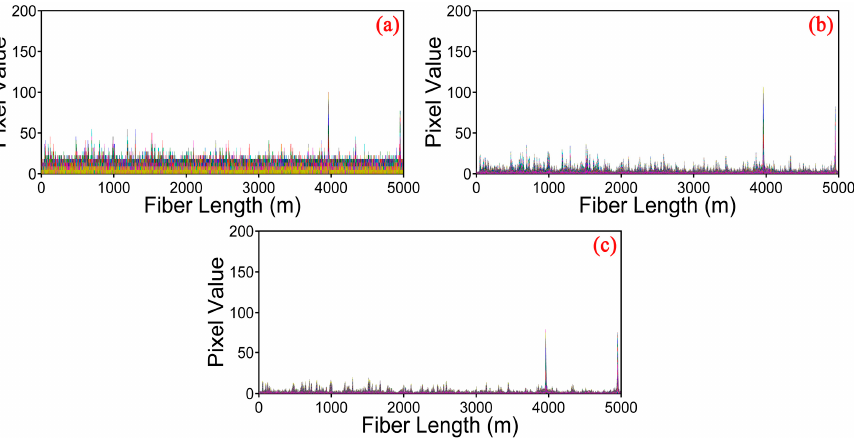
Figure 8. Location information for two PZT vibrations detection under different methods. ( a ) Moving differential method; ( b ) Curvelet denoising method based on the traditional thresholding; ( c ) Curvelet denoising method based on the optimized thresholding.